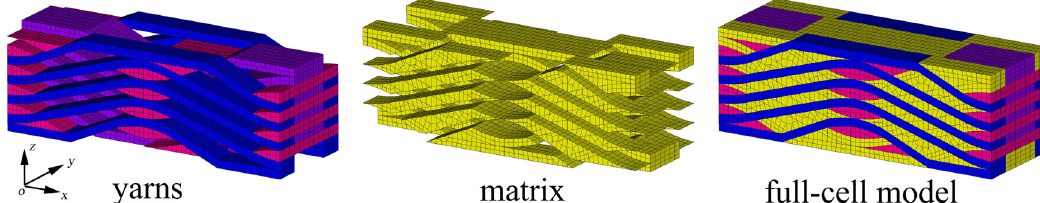
Figure 3: Finite element model of 2.5D woven